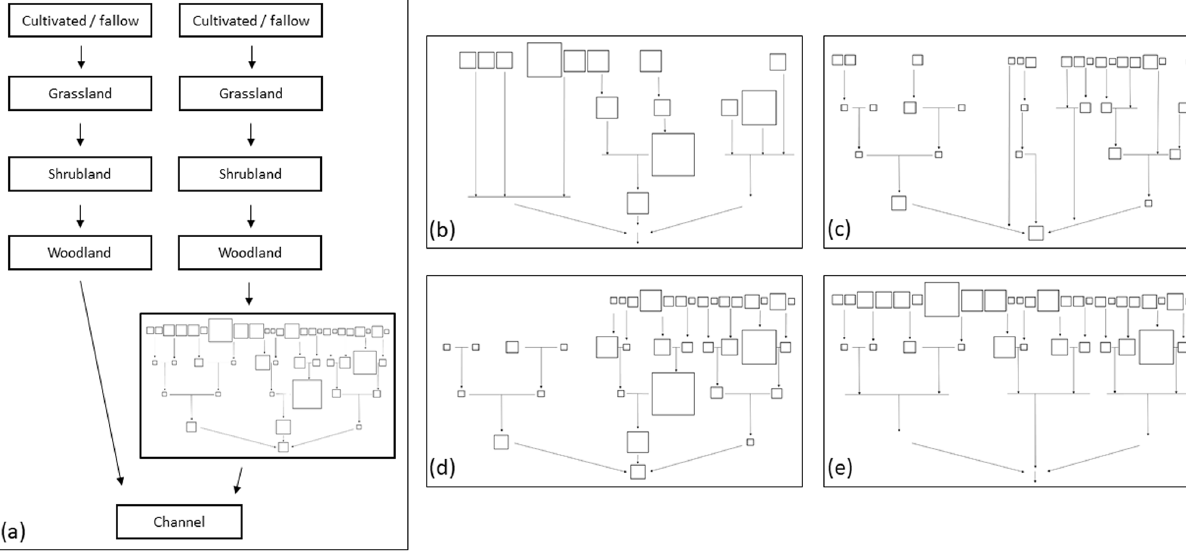
Hydrol. Earth Syst. Sci., 26, 5555–5575, 2022